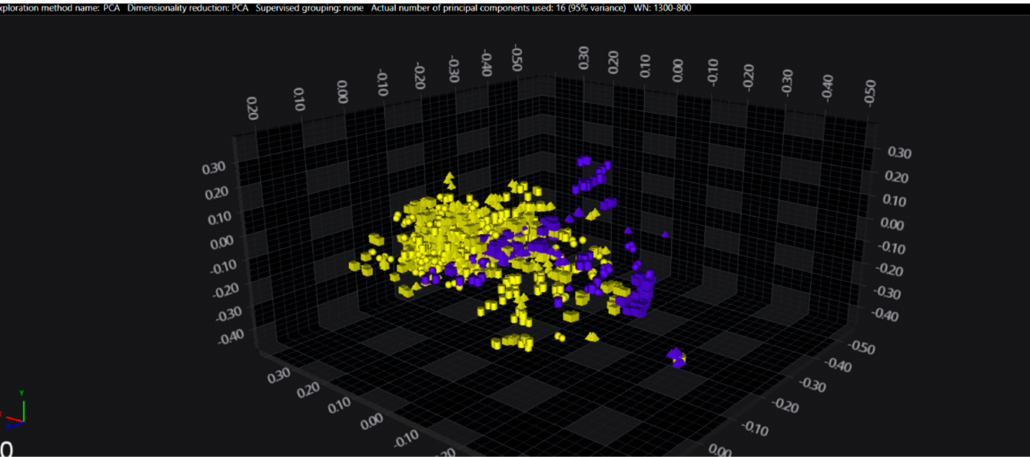
Figure 2. PCA of the O:4 serogroup (blue = Paratyphi B, yellow = other